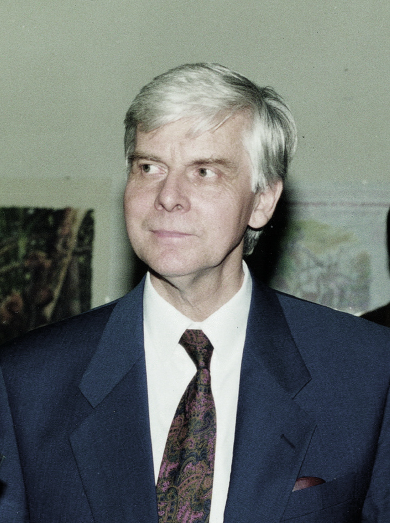
Figure 9. Prof. Dr Hans-Jürg Kuhn was the first scientific director of the German Primate Center and headed the institute from 1977 to 1996 (picture from DPZ archive).